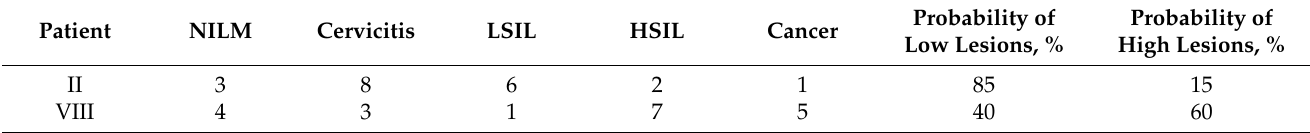
Table 5. Distribution of votes for each diagnosis in clinical cases for patients II and